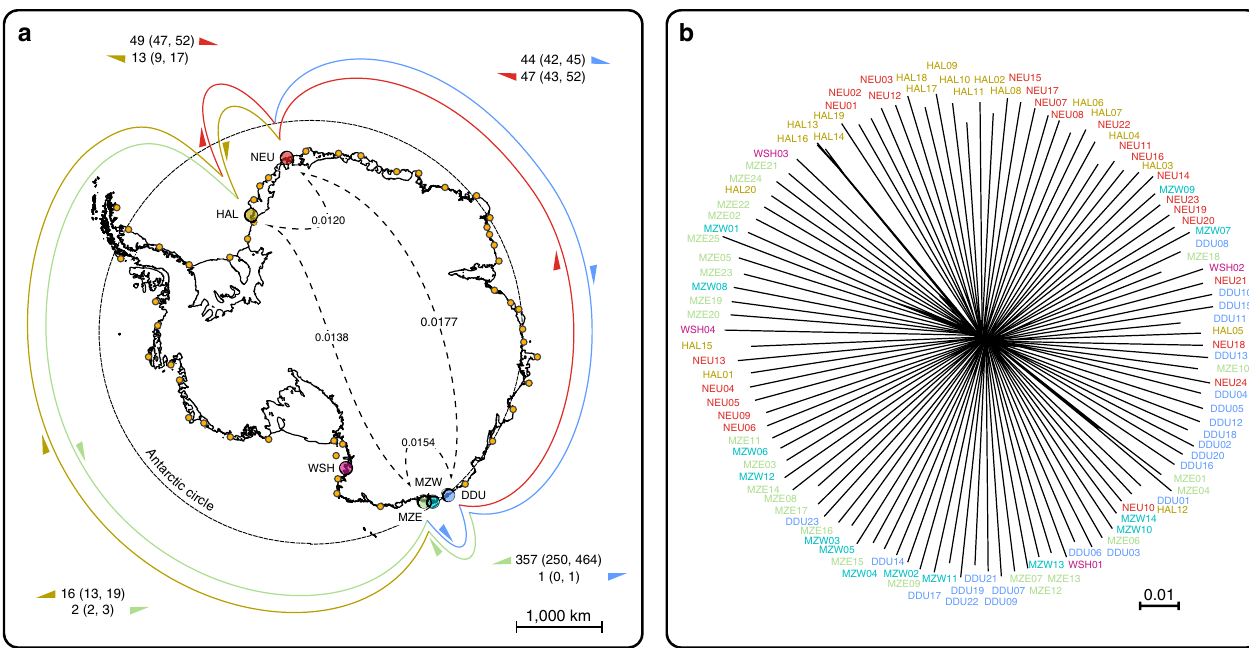
Figure 1 | Drift and mixing concur to keep a high degree of worldwide homogeneity in the Emperor penguin. All currently known Emperor penguin colonies 20,35 are represented by orange dots; sampled colonies by coloured circles. ( a ) Estimated pairwise migration rates (outer coloured links) and Fst (inner dashed links) between sampled colonies. Migrations as estimated from joint allele-frequency spectra. Colours refer to the receiving populations (DDU, Pointe Ge´ologie near Dumont D’Urville station; HAL, Halley Bay; MZW, Mertz West; MZE, Mertz East; NEU, Neumayer; WSH, Cape Washington). Dashed circle: Antarctic polar circle (S66 (cid:2) 33’). ( b ) Neighbour-net based on pairwise identity-by-state between all sampled individuals. Branch lengths represent pairwise Hamming distances. Colours correspond to colonies on map a .